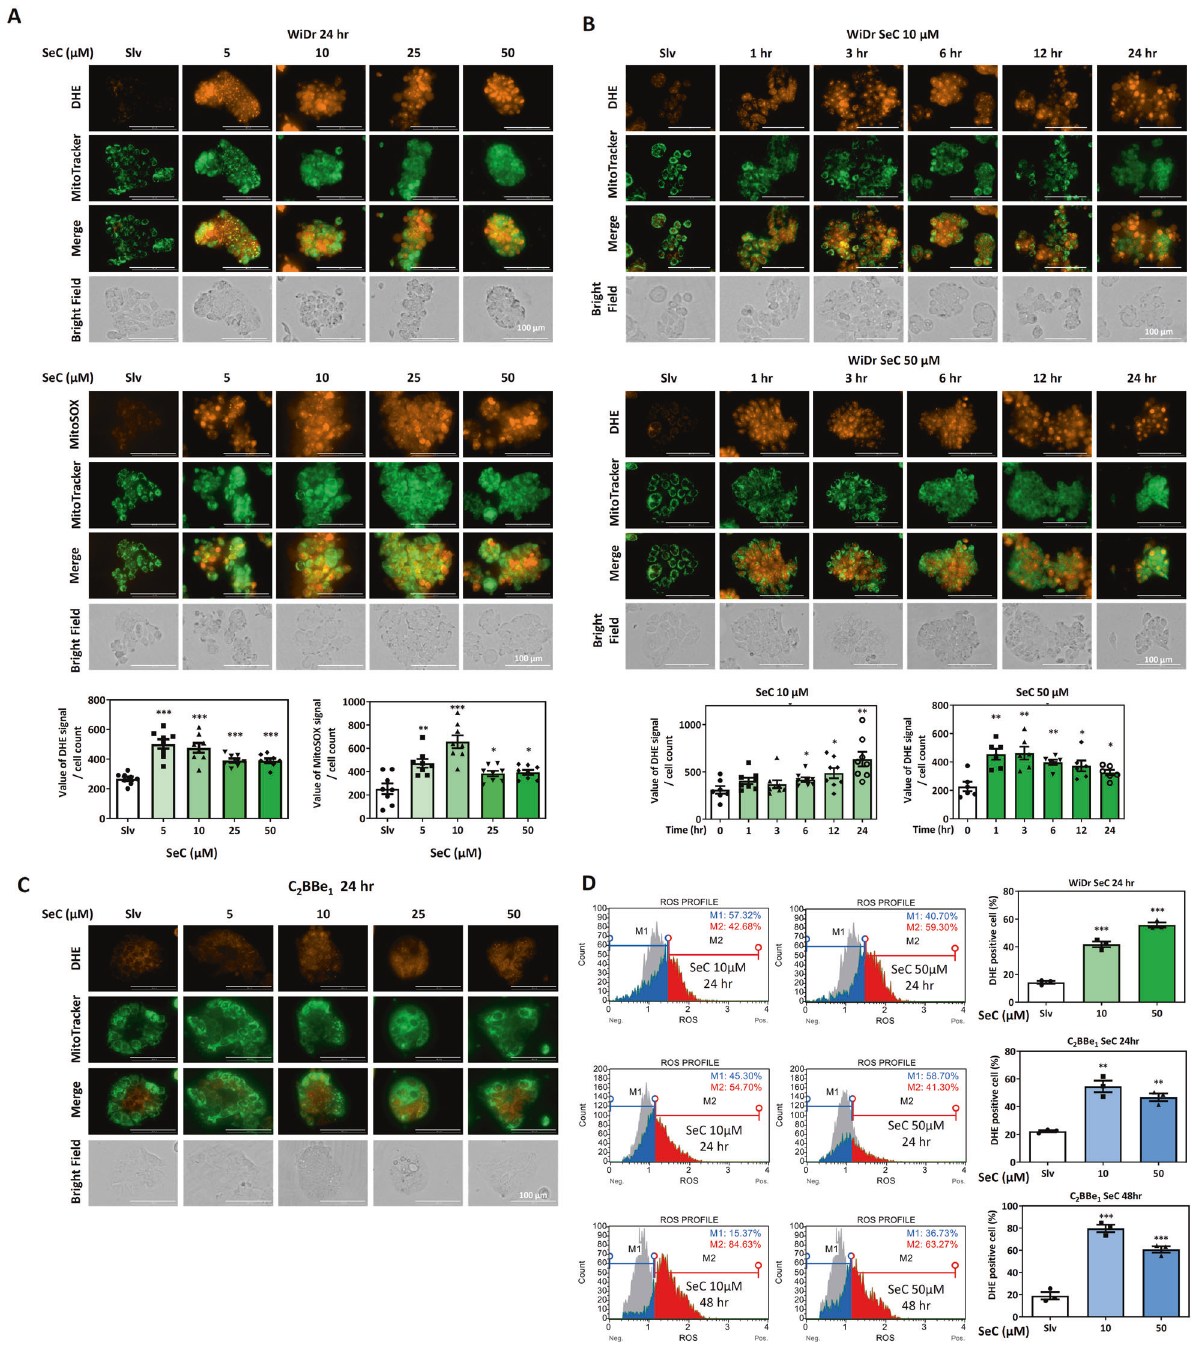
Fig. 3 Superoxide production increased in Nrf2-addicted cells after SeC treatment. A , B Colocalization of DHE/MitoSOX and Mitotracker after exposure to various doses of SeC in Nrf2-addicted WiDr cells over different time courses. The cell count each in fi eld was measured using Image J. The fl uorescence intensity was normalized with cell number from eight fi elds. All quanti fi ed results are expressed as mean ± SD. (* P < 0.05, ** P < 0.01, *** P < 0.001, compared with solvent control for each cell type). C DHE staining in C 2 BBe 1 cells after 24 h of SeC treatment. D The percentage of DHE-positive cells determined through fl ow cytometry in SeC-treated WiDr and C 2 BBe 1 cells (* and + P < 0.05, ** and ++ P < 0.01, * ** and +++ P < 0.001, n = 3, compared with solvent control for each cell type). Signi fi ca n ce was determined by an unpaired t test. The values were presented as average ± SD from three independent